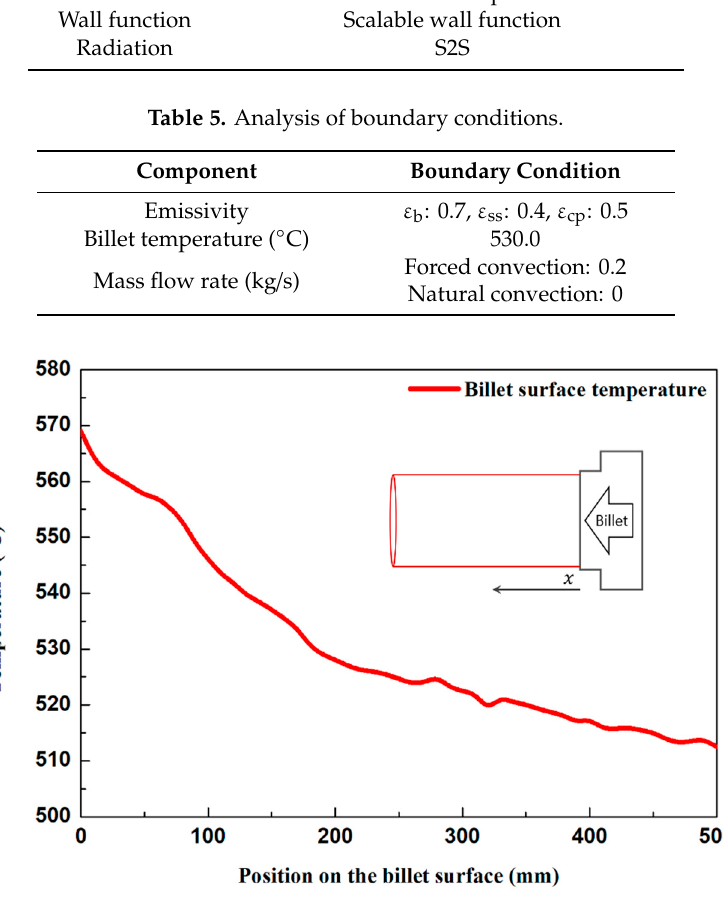
Figure 5. Temperature distribution on the billet surface.